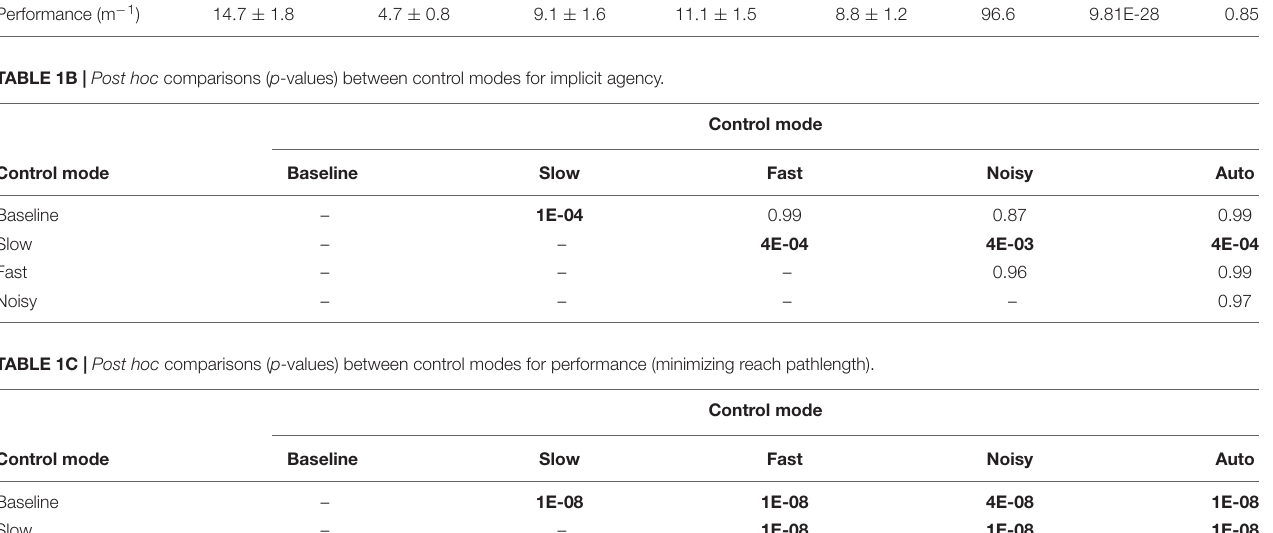
The general effects of high versus low implicit agency on path length position and velocity over the reach cycle are shown in Figure 10 . The mean path kinematic trajectories are shown across the top (high) 50% of trials in agency versus the bottom (low) 50% of trials across all participants and control modes. High agency trials generally demonstrate shorter path length trajectories and slower path length velocities throughout the reach cycle. Figure 11 indicates that high agency trials produce significant ( p < 0.001) reductions in the following movement features of path length: maximum path length, mean path length velocity, and maximum path length velocity. These high agency effects were desirable given the performance task was to minimize path length, ideally by following a minimum path length trajectory of 0.32 m at a constant velocity of 0.08 m/s. Figure 11 also indicates a significant increase ( p < 0.05) in movement smoothness in path length with high